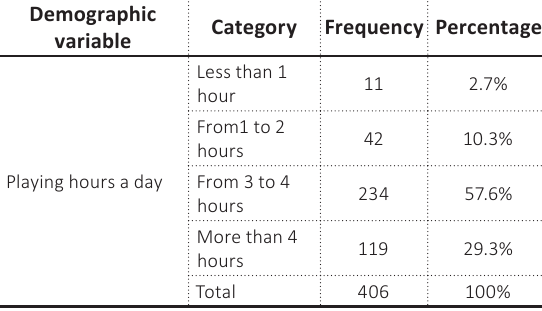
Table 4. Distribution of sample based on their